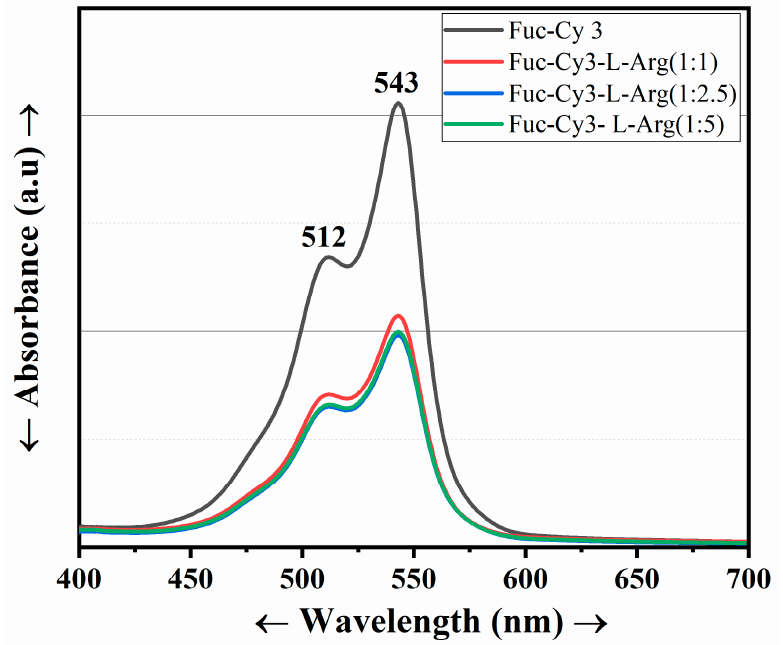
Figure 6. Fluorescence intensities of the Fuc-Cy3 dye and Fuc-Cy3-L-Arg (1:1, 1:2.5, and 1:5) complexes. 3.5. Biocompatibility Test of the Fuc-L-Arg Fiber Complex in HeLa Cells Prior to in vitro and in vivo studies of the material, the cytotoxicity of the biomaterial was a significant factor for consideration. Generally, fucoidan exhibits non-toxicity due to its varied biological properties and wide bioapplications in the food and pharmaceutical industries [22, 39]. Previous reports have found that L-arginine can exhibit >80% biocom- patibility up to 35 mg [34]. In this study, biocompatibility tests were carried out for pris- tine oligo-fucoidan, pristine L-arginine, and the Fuc-L-Arg complex prior to cellular up- take. The cell viabilities were >80% for various concentrations (5, 10, 25, 50, 100 µg/mL obtained from 1mg/mL stock concentration) in pristine oligo-fucoidan and L-arginine as well as Fuc-L-Arg fiber (1:1, 1:2.5) complexes. In addition, Fuc-L-Arg (1:5) complexes also exhibited >80% cell viability at lower concentrations (5 and 10 µg/mL), whereas at higher concentrations (25, 50, 100 µg/mL), the Fuc-L-Arg (1:5) complex exhibited <80% cell via- bility (Figure 7). This is due to higher internalization of the complex into the HeLa cell, and leads to the exhibition of its potential biological activities like anti-cancer activity. Further, the statistical analysis was carried out at higher concentrations such as 25, 50, and 100 µg/mL between fucoidan, L-arginine, and Fuc-L-Arg complexes (1:1, 1:2.5, and 1:5). There is a significant difference of about p < 0.05 between fucoidan and L-arginine and Fuc-L-Arg complexes (1:2.5 and 1:5) at the concentration of 25 µg/mL; whereas at the con-